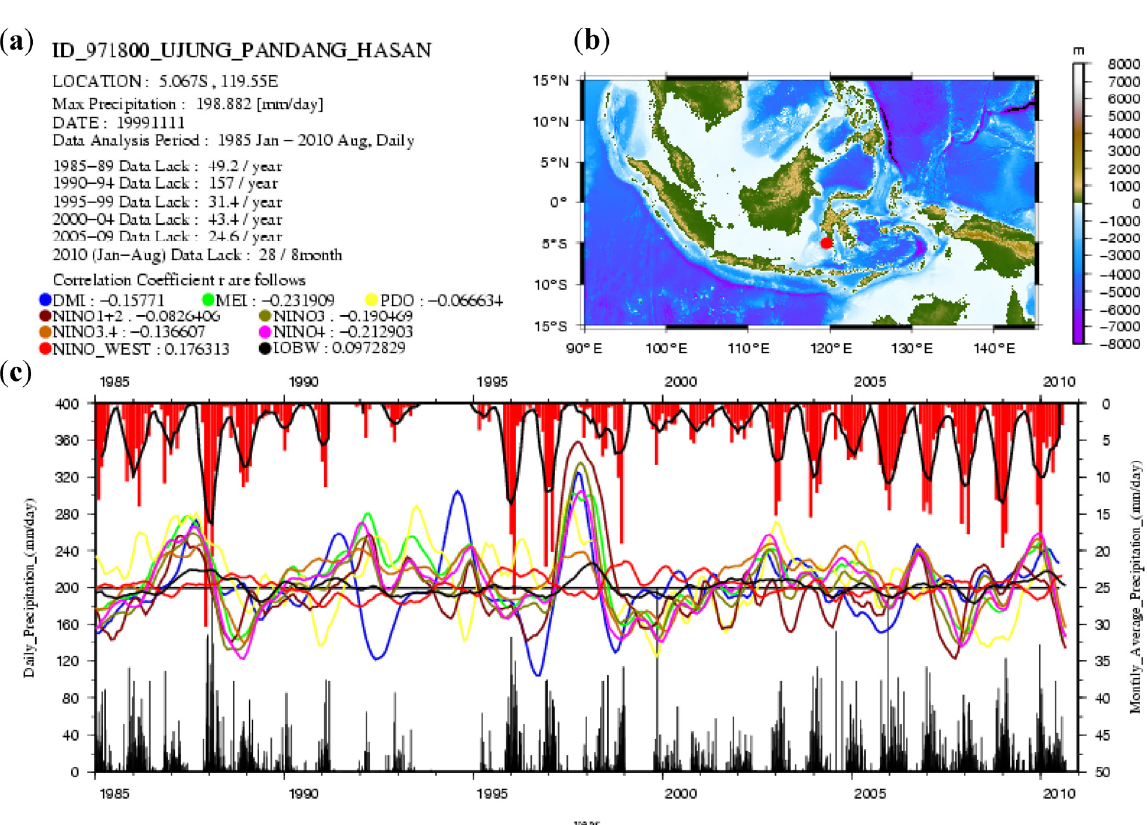
( b ) the station location and ( c ) the observed daily rainfall (black bars), the mean daily rainfall for each month (red bars), the 5-month running mean of the mean daily rainfall for each month (black solid line), and the time series of the